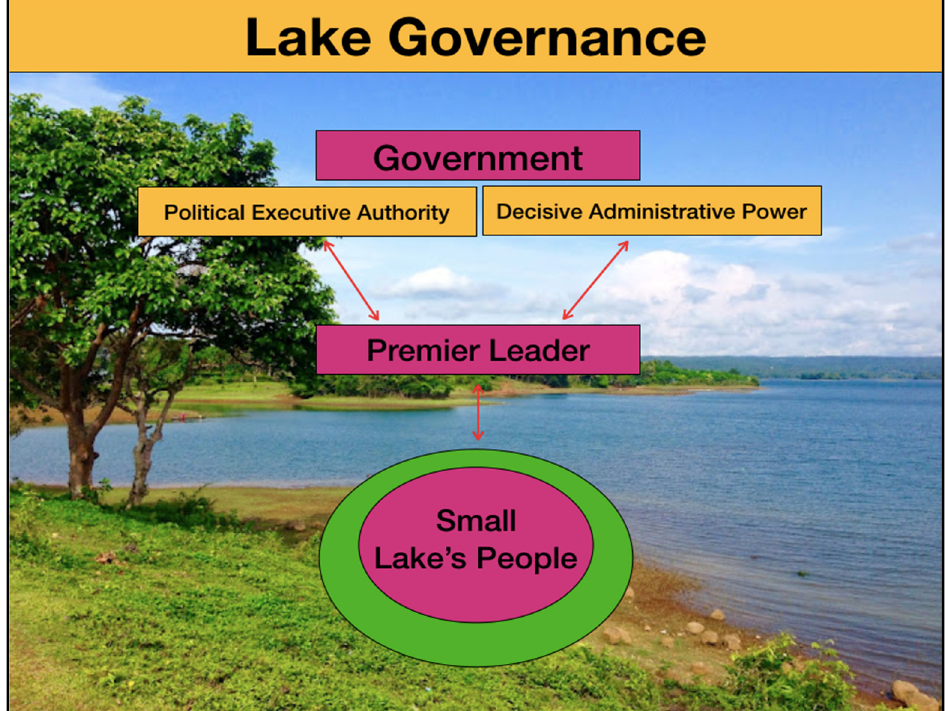
Figure 2. Lake governance: government, premier leader and small lake’s people.